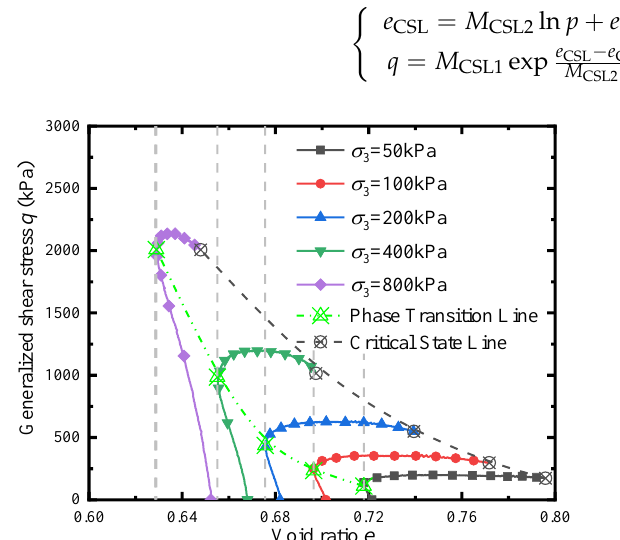
Figure 13. e-q relationships under drained conditions.